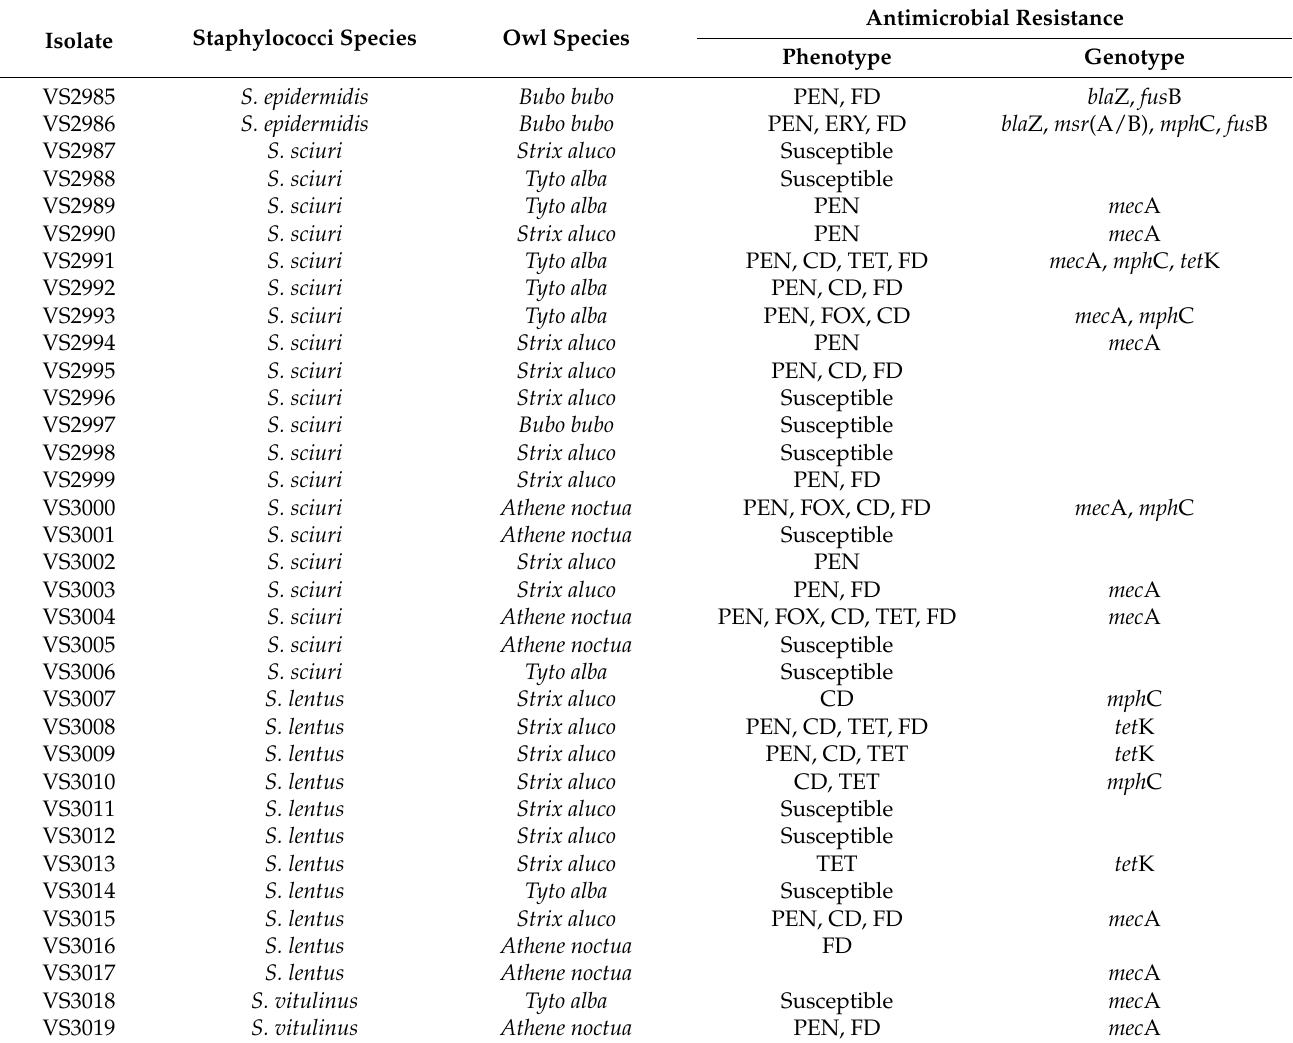
Table 3. Owl and staphylococci species identification and resistance genes